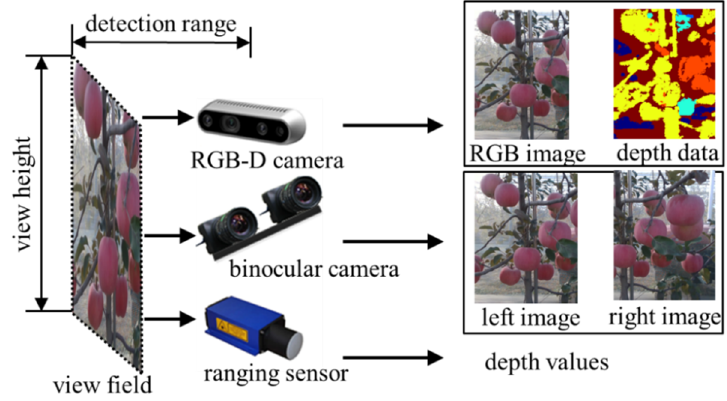
Figure 2. Typical visual units of harvesting robots. Table 1. Characteristic list of some harvesting robots’ visual